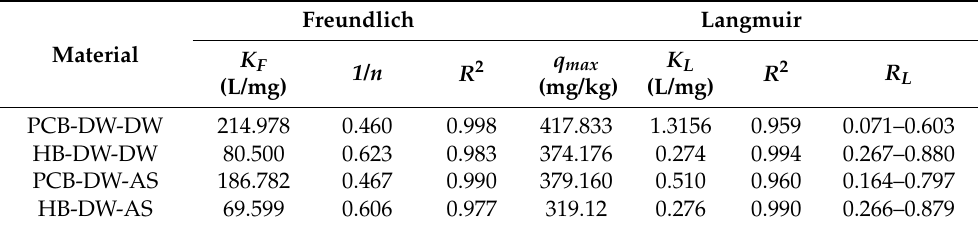
Table 5. Parameters for Freundlich and Langmuir isotherms of phosphate adsorption on PCB-DW and